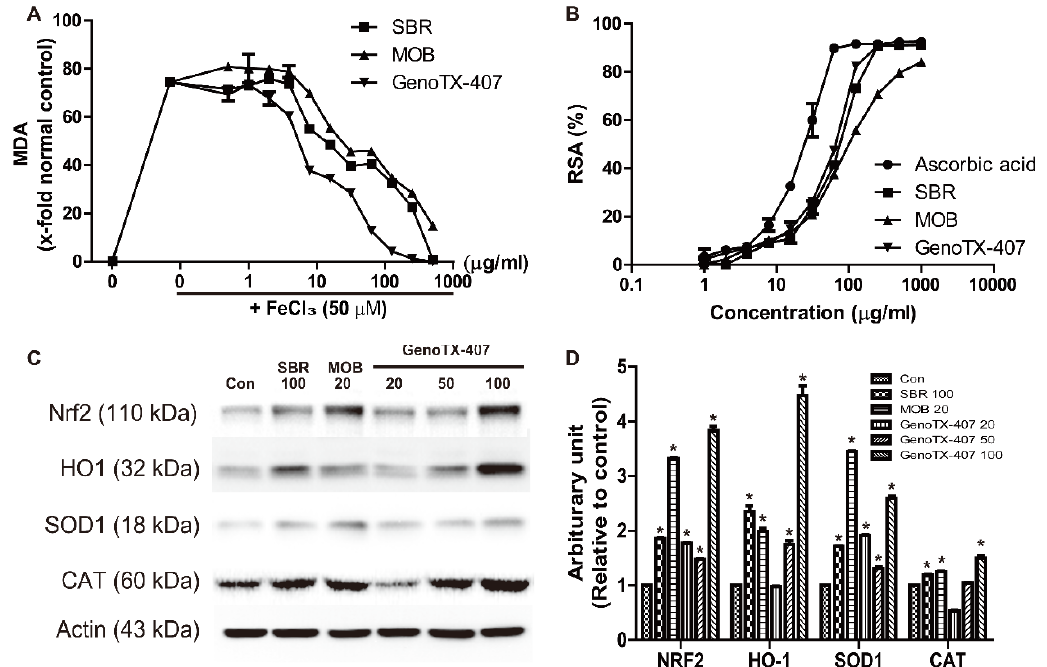
Figure 3. Antioxidant activities of SBR, MOB, and GenoTX-407. ( A ) Inhibitory effect on FeCl 3 -induced lipid peroxidation (TBARS production) ( B ) 1,1-diphenyl-2-picrylhydrazyl (DPPH) radical-scavenging activity in 30 min. ( C , D ) Western blotting to check the expression of Nrf2, HO-1, SOD1, and CAT in response to individual treatments ( C ). Band densities normalized to GAPDH ( D ). * Significantly different from vehicle controls ( p < 0.05). SBR, Scutellaria baicalensis root; MOB, Magnolia officinalis barks; GenoTX-407, combination of SBR and MOB.